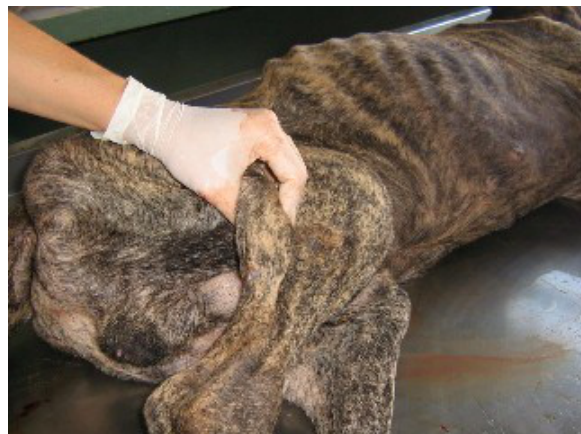
Figure 4. Dog showing alopecia and ulcerative